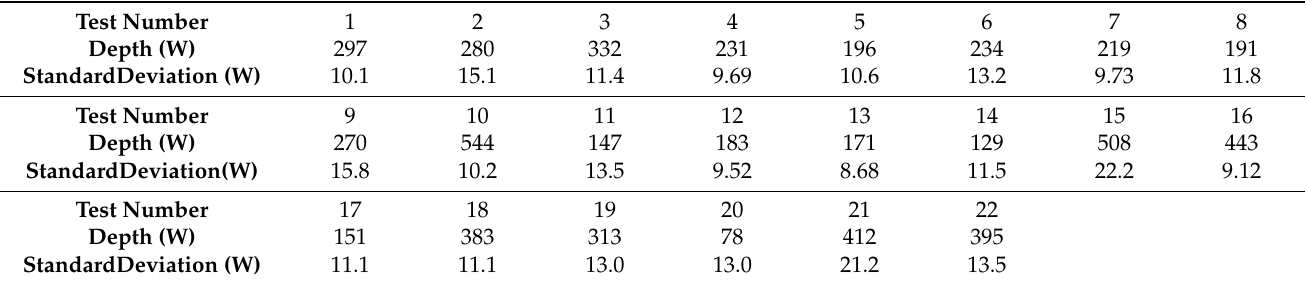
Table 5. Depth results of the orthogonal